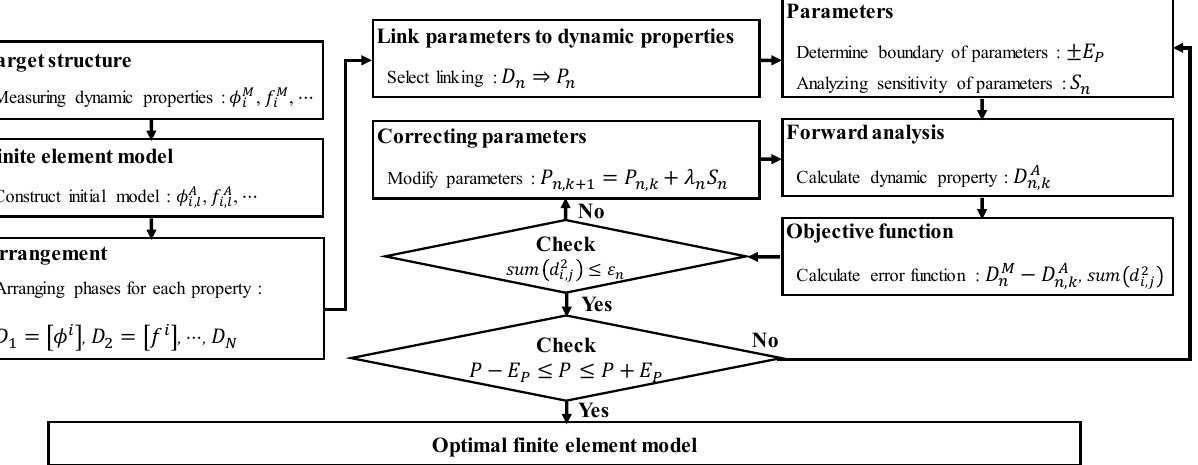
Figure 6. Numerical model updating algorithm based on the univariate search method.